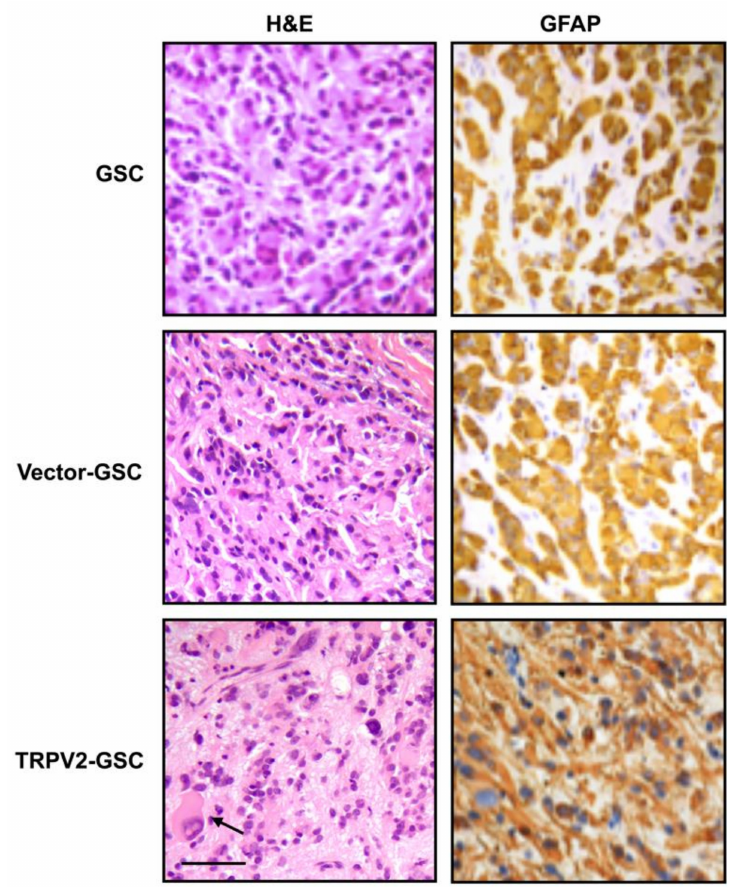
Figure 3. Enhancement of the astroglial phenotype is evident in tumors derived from transplanted TRPV2-transfected GSC lines. GFAP expression was analyzed in tumor xenograft sections stained with H & E. Bar: 50 µ m. Arrow denotes multinucleated giant cells (figure is from